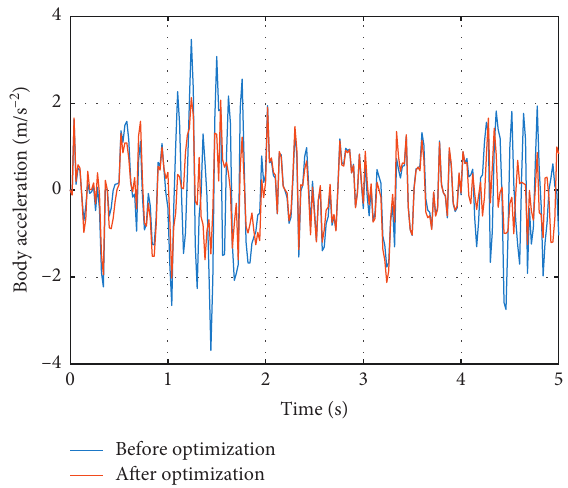
Figure 10: Body acceleration before and after